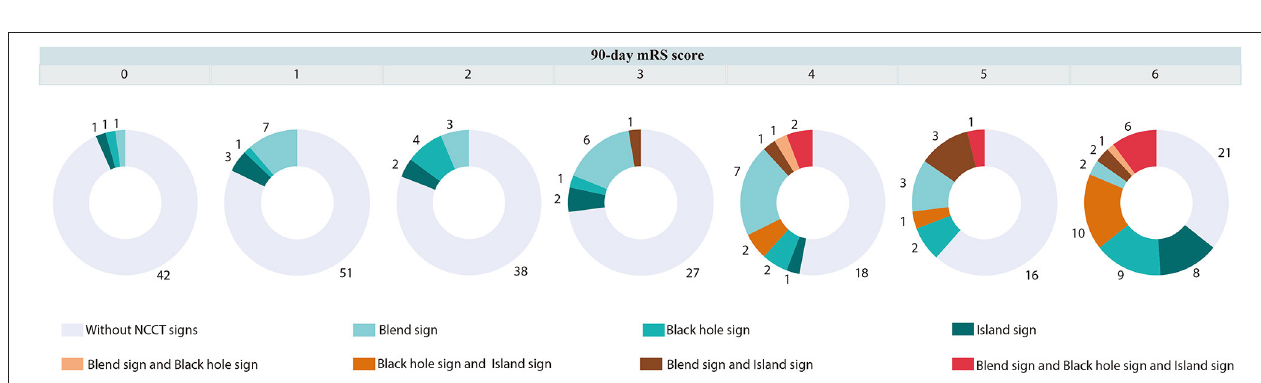
Scale (NIHSS) score, age, intraventricular hemorrhage, oral anticoagulation, lobar ICH volume ≥ 30 ml, and non-lobar